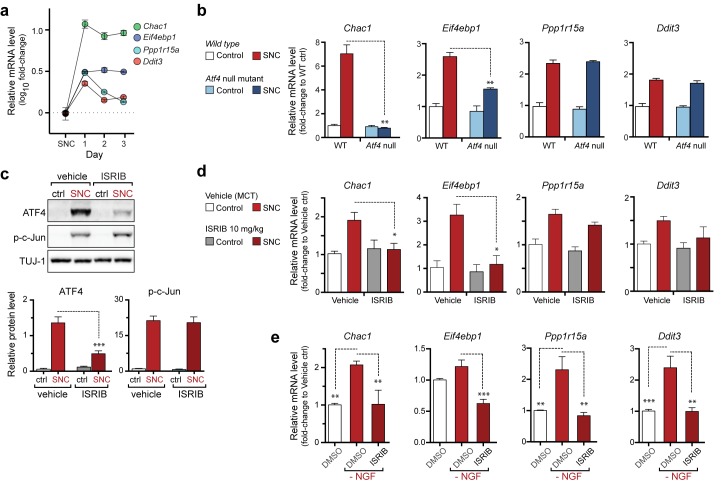
The PERK-mediated ISR regulates mRNA levels of a subset of ATF4 target genes.(a) qRT-PCR of L4 DRG confirms the upregulation of each of four ISR-related mRNAs (Chac1, Eif4ebp1, Ppp1r15a, and Ddit3) over the first 3 days after SNC (n = 3/condition). (b) Real-time qPCR for four putative ATF4 target genes in ATF4-null and wild-type mouse DRGs 24 h following SNC (n = 3/condition). (c–d) Dosing with ISRIB reduces induction of ATF4 protein and the mRNA of a subset of its putative target genes in associated DRGs following SNC. (c) Immunoblots of L3/L4 DRGs from ISRIB-treated mice 16 h post-SNC (n = 3/condition). (d) Real-time qPCR of mouse DRGs 16 h following SNC (n = 3/condition). Mice were dosed with vehicle or ISRIB (10 mg/kg, 1 h pre-SNC and 12 h post-crush). (e) qPCR of NGF-deprived embryonic DRG cultures reveals upregulation of mRNA of four putative ATF4 target genes, blocked by 400 nM ISRIB (n = 6–8/condition, two independent experiments). Data are represented as mean ± SEM. One-way ANOVA with post-hoc Bonferroni was used for statistical comparisons. *p<0.05, **p<0.01, ***p<0.001.